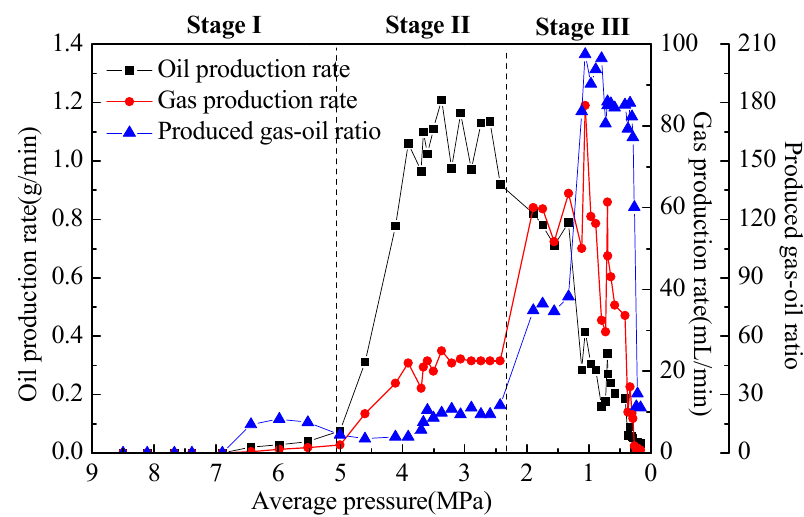
Figure 4. Characteristics for foamy oil depletion development (taking test 1 as an example).